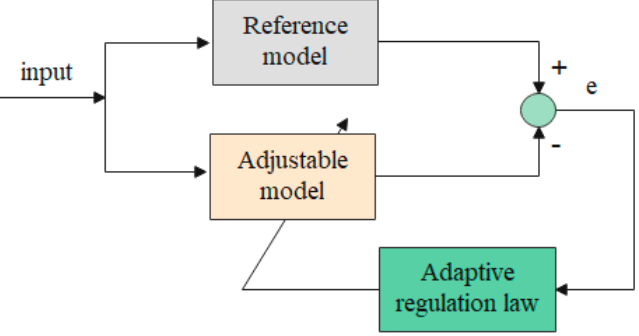
Figure 1. Block diagram of model reference adaptive system algorithm.